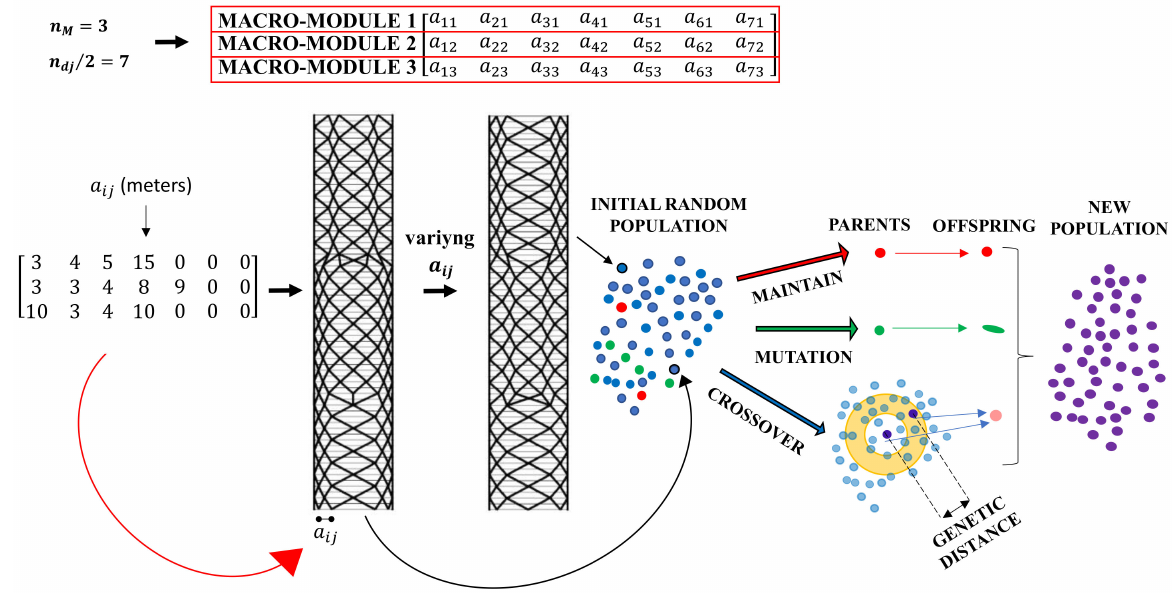
Figure 8. Framework of the automatic random generation